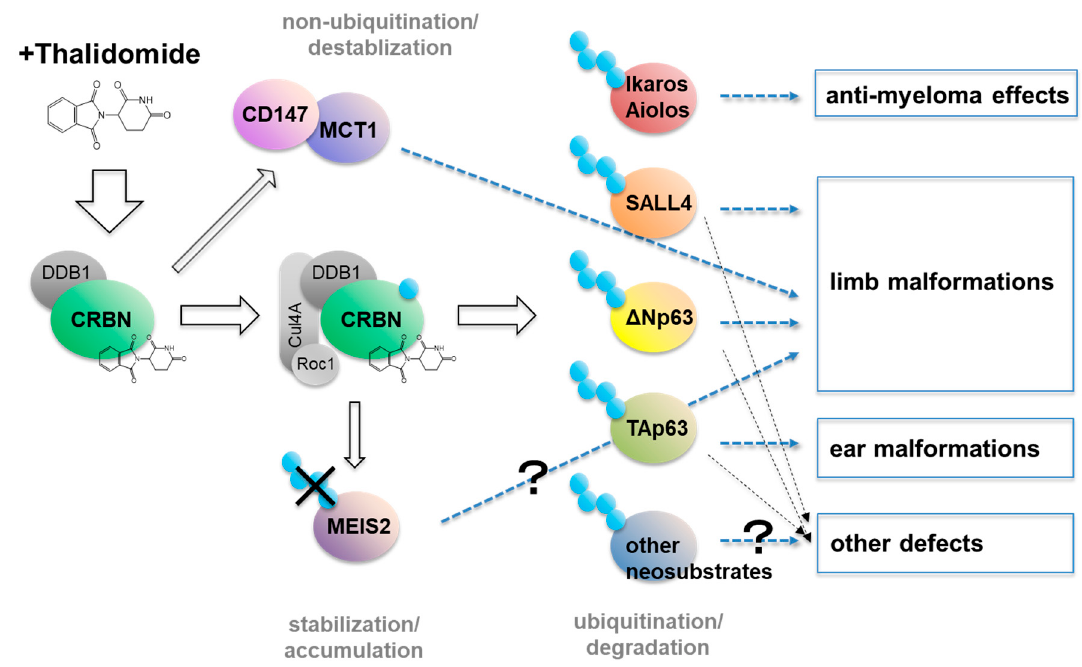
Figure 2. Model of the molecular mechanism of thalidomide. Thalidomide exerts multiple functions after binding to CRBN: (i) the non-ubiquitination process of destabilizing the CD147/MCT1 complex, (ii) the blockade of ubiquitination that stabilizes MEIS2, and (iii) the ubiquitin-dependent degradation of several neosubstrates including SALL4 and p63. These multiple downstream targets of the thalidomide–CRBN axis result in the various effects of thalidomide.